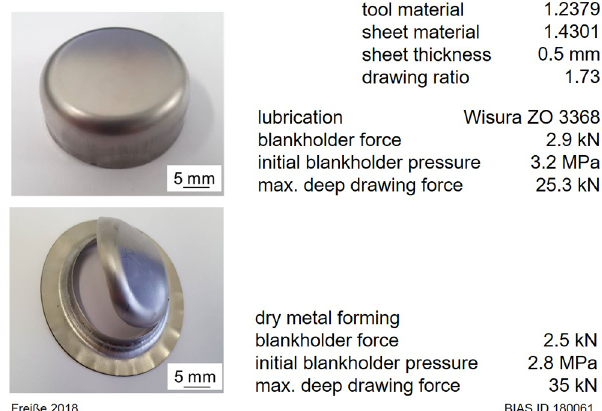
Fig. 20. Deep drawing by using tool out of tool steel and a drawing clearance of 0.7 mm.